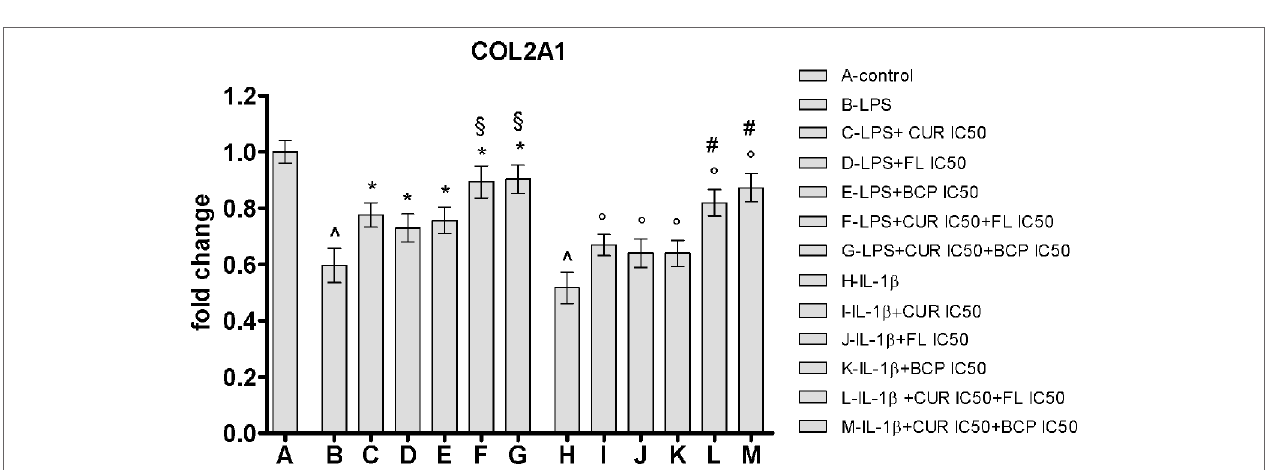
FIgURE 9 | COL2A1 mRNA expression evaluated by RTqPCR. Data are expressed as fold change versus control. Values are expressed as the mean ± SD. ^ p < 0.001 versus control; * p < 0.001 versus LPS; § p < 0.001 versus LPS + CUR (curmin) IC 50 , LPS + FL (flavocoxid) IC 50 and LPS + BCP (β-caryophyllene) IC 50 . ° p < 0.001 versus IL-1β; # p < 0.001 versus IL-1β + CUR (curmin) IC 50 , IL-1β + FL (flavocoxid) IC 50 and IL-1β + BCP (β-caryophyllene) IC 50